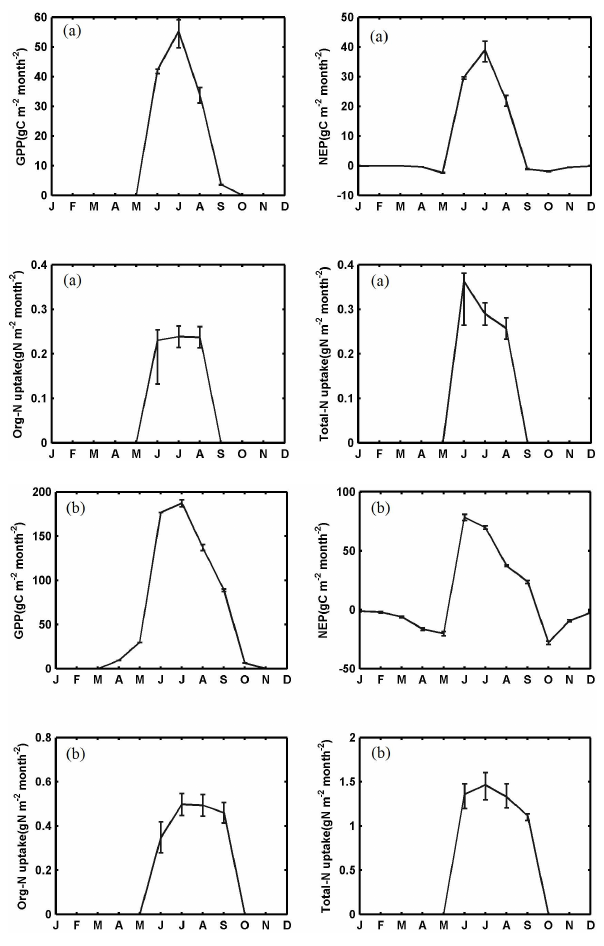
Fig. 5. Uncertainty analysis of the organic nitrogen uptake module- related parameters, showing the ensemble simulations mean, upper and lower bounds. GPP, NEP, the organic nitrogen uptake and the total nitrogen uptake are illustrated. (a) is the tundra site US-Brw and (b) is the boreal forest site UCI